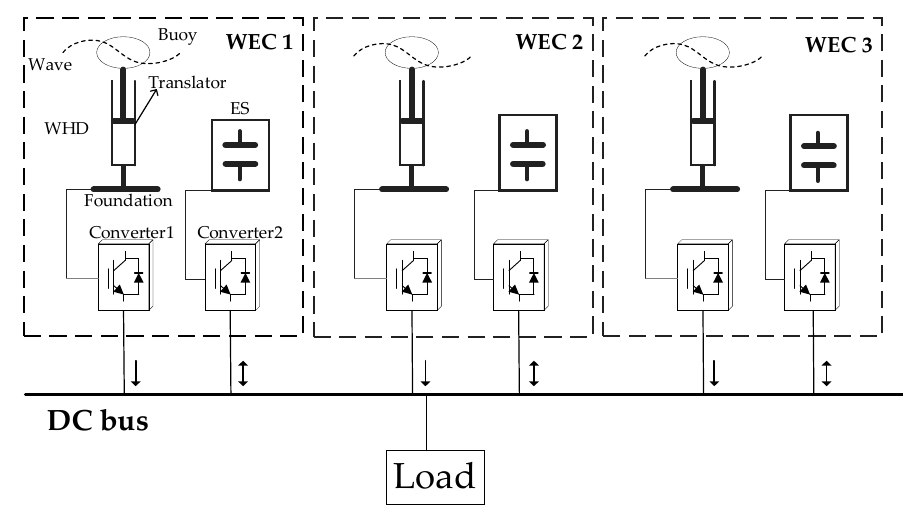
Figure 2. Structure of the WECs array.